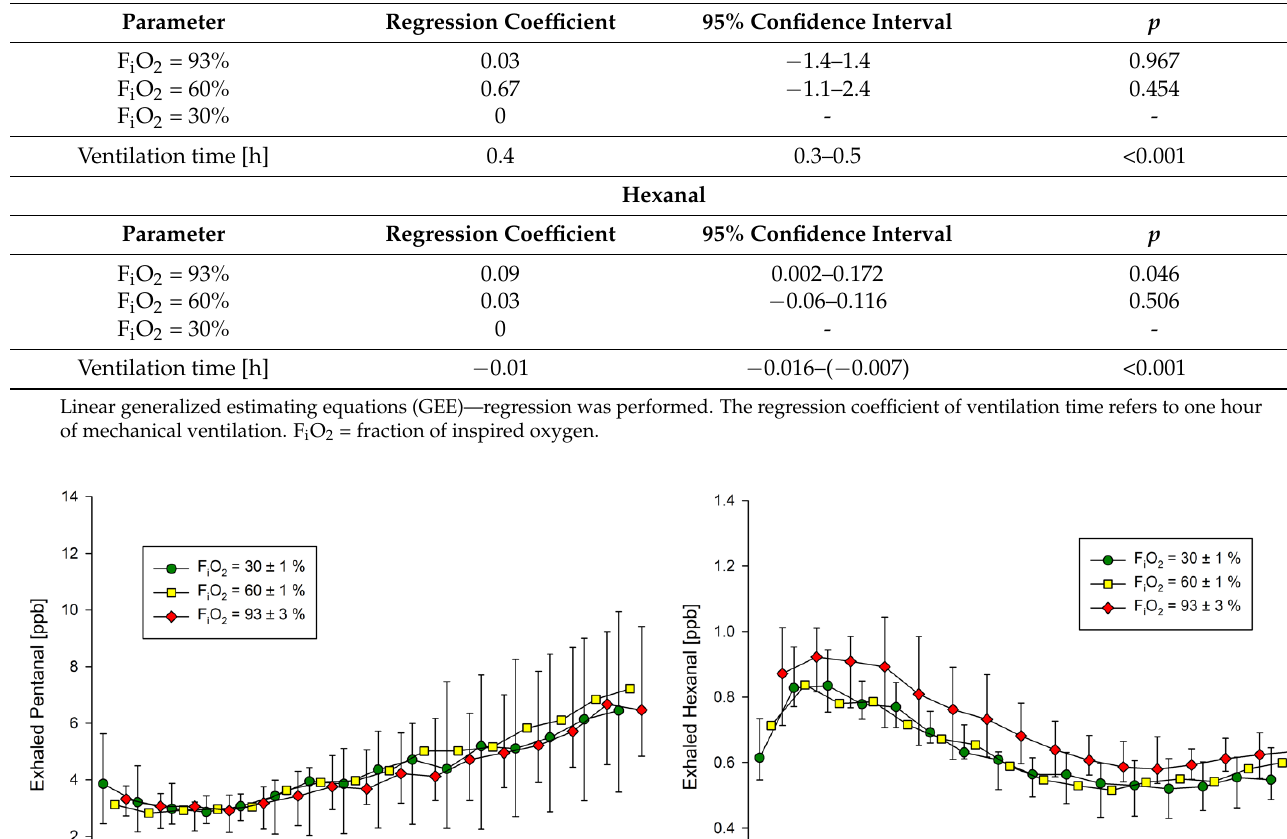
Table 1. Influence of inspired oxygen and mechanical ventilation on pentanal and hexanal exhalation. Pentanal